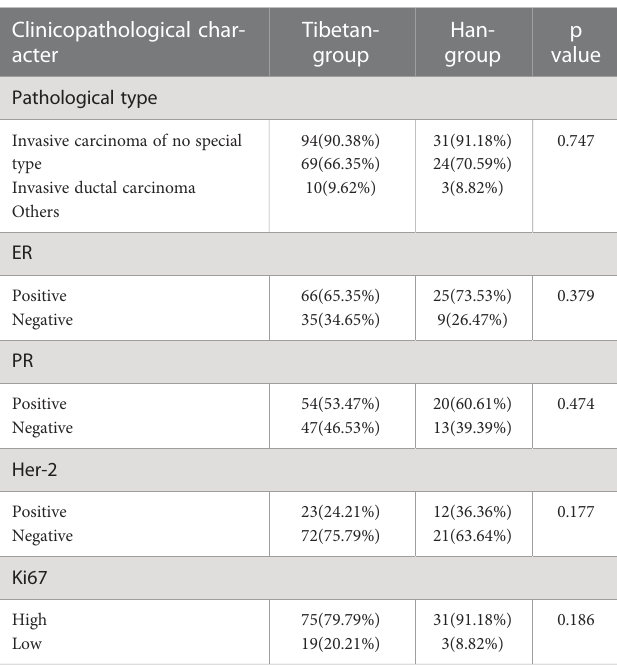
TABLE 2 Clinicopathological characteristics in Tibetan-group and Han- group[n(%)].